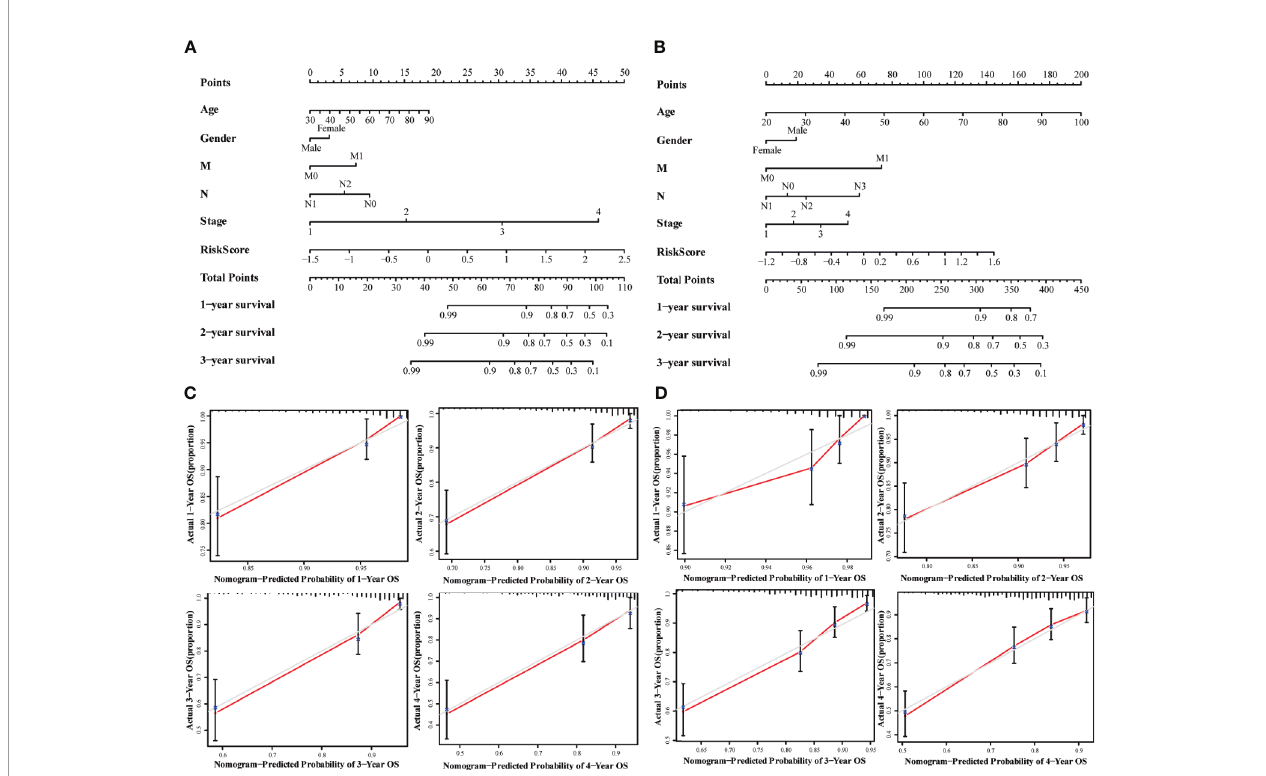
FIGURE 7 | Nomograms for predicting 3-year survival in the TCGA (A) and GSE39582 (B) datasets. Calibration curves for the nomogram predicting 1-4 years survival in the TCGA (C) and GSE39582 (D)